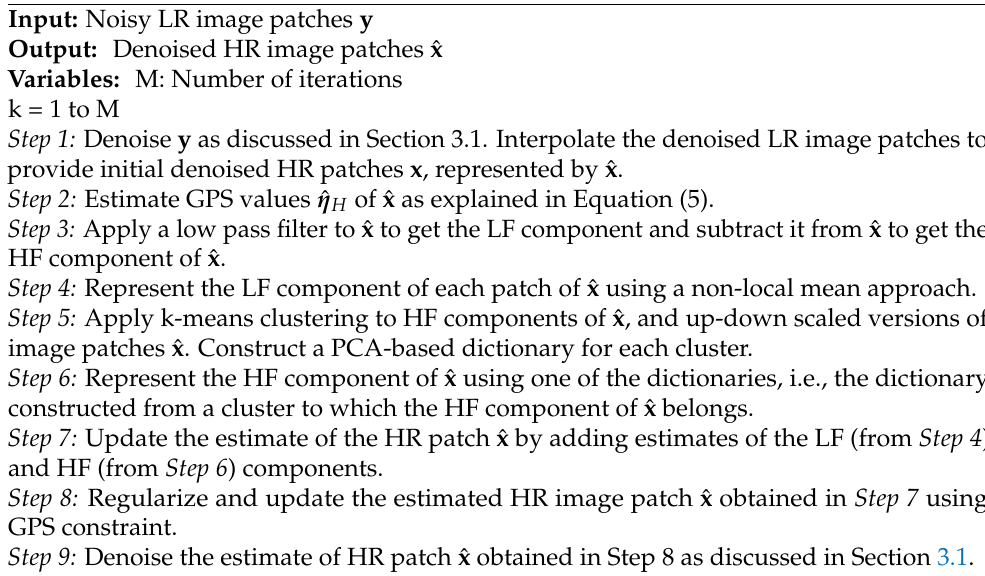
Algorithm 1 Estimate denoised HR